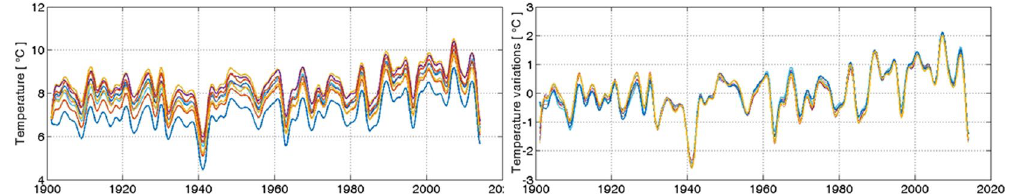
Figure 11. 100-year temperature variations in a 100 km region surrounding Gräfenberg from CRU TS3.23 36 , after applying a 13-month Butterworth low pass filter. Left, absolute temperature variations, right, temperature variations with mean